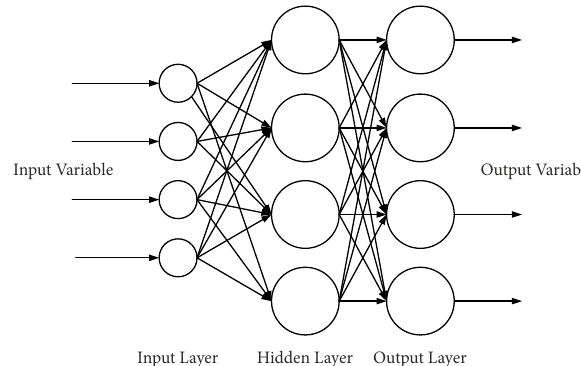
Figure 1. Structure of BP neural network